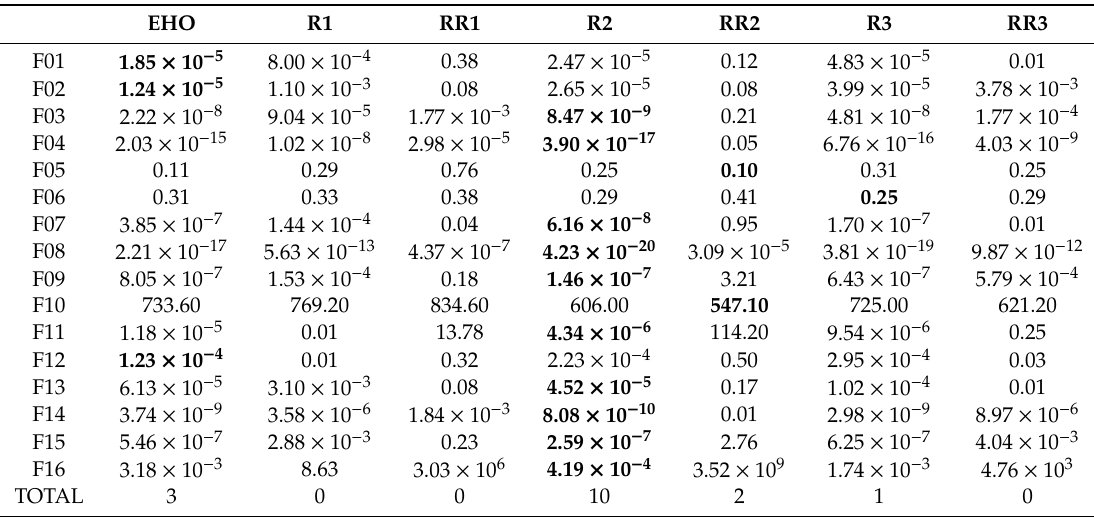
Table 5. Standard values obtained by EHO and six improved methods with D =